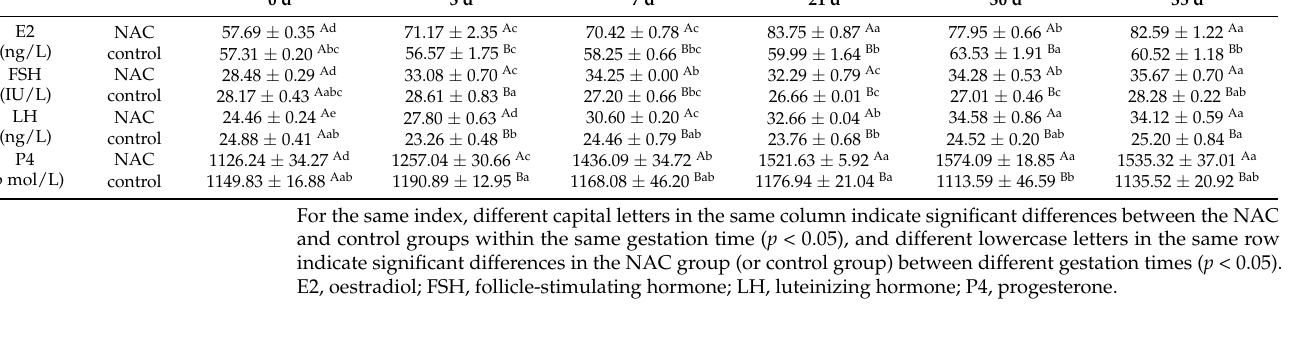
Table 3. Effects of NAC on serum biochemical parameters of does at different times of